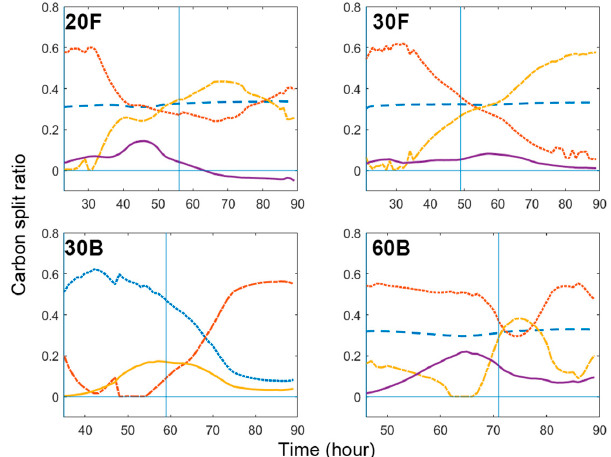
Figure 9. Profiles of flux split ratios (on a per carbon basis) of four major carbon-consuming activities/pathways: (1) pyruvate dehydrogenation (dashed line); (2) acid production (solid line); (3) PHB synthesis (dotted line); (4) TCA cycle (dash-dot line).